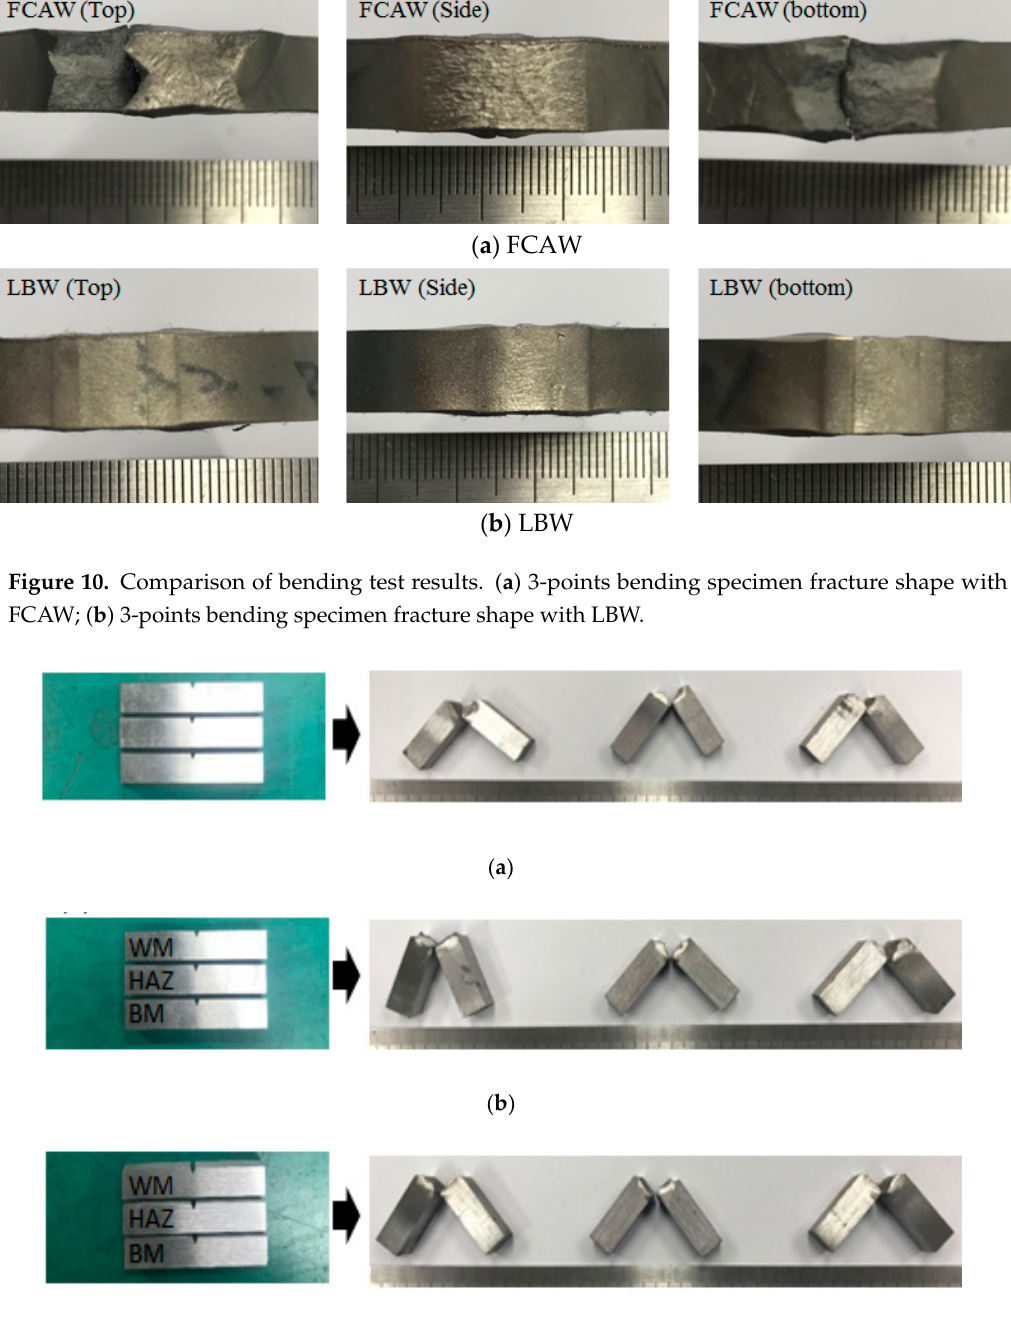
Figure 9. The results of 3-points bending test.